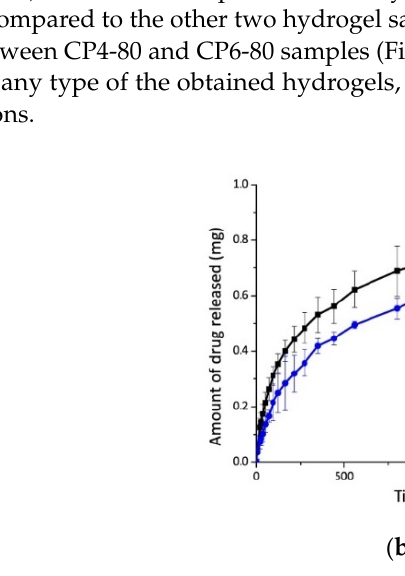
Figure 7. Diflunisal release profiles for hydrogels CP4-4 and CP4-80 ( a ); and CP4-80 and CP6-80 ( b ). In the sample abbreviation, the first number after “CP” indicates the quantity of freeze–thawing cycles, and the second one indicates the temperature of freezing. Reproduced from [35], with permission from JoVE, 2021.